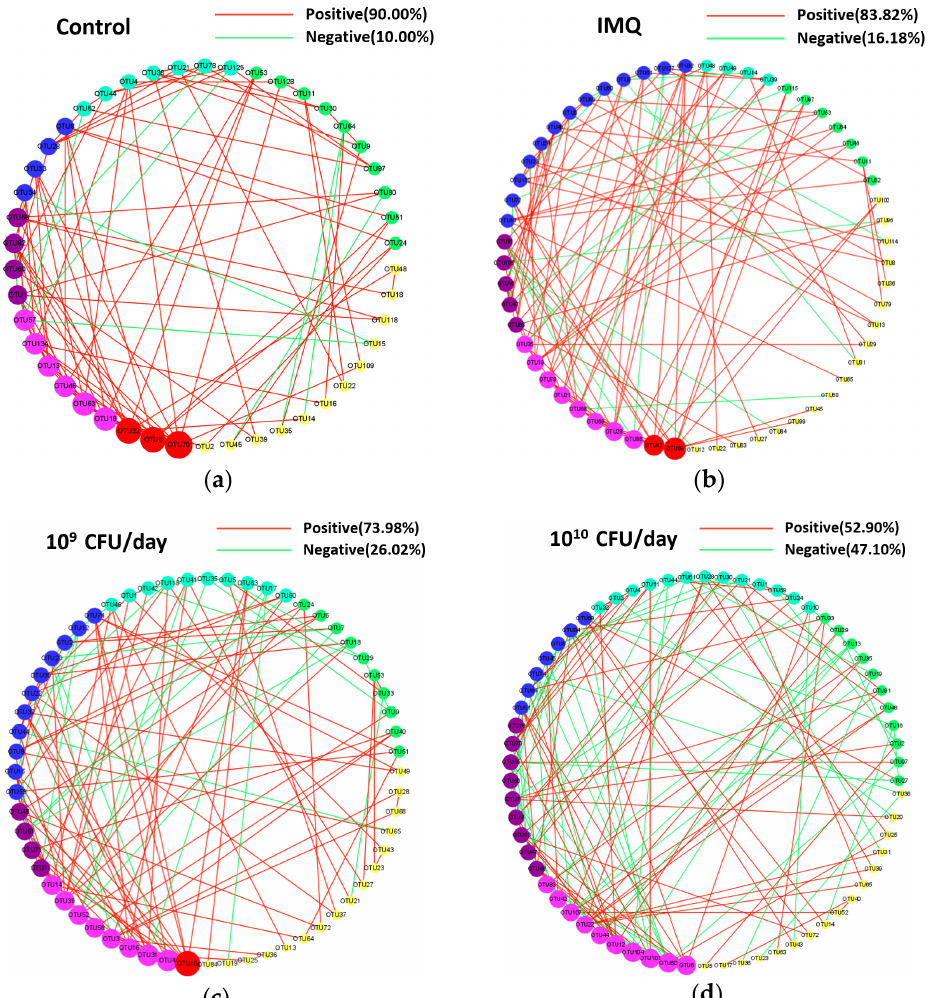
Figure 11. Effects of CCFM683 treatment on dominant microorganisms. The co-occurrence network structure of gut bacteria in ( a ) control, ( b ) IMQ, ( c ) 10 9 CFU/day CCFM683, and ( d ) 10 10 CFU/day CCFM683 groups. The edge colors indicate positive (red) or negative (green) correlations, which depend on the Pearson’s correlation coefficient. The node size represents the degree.